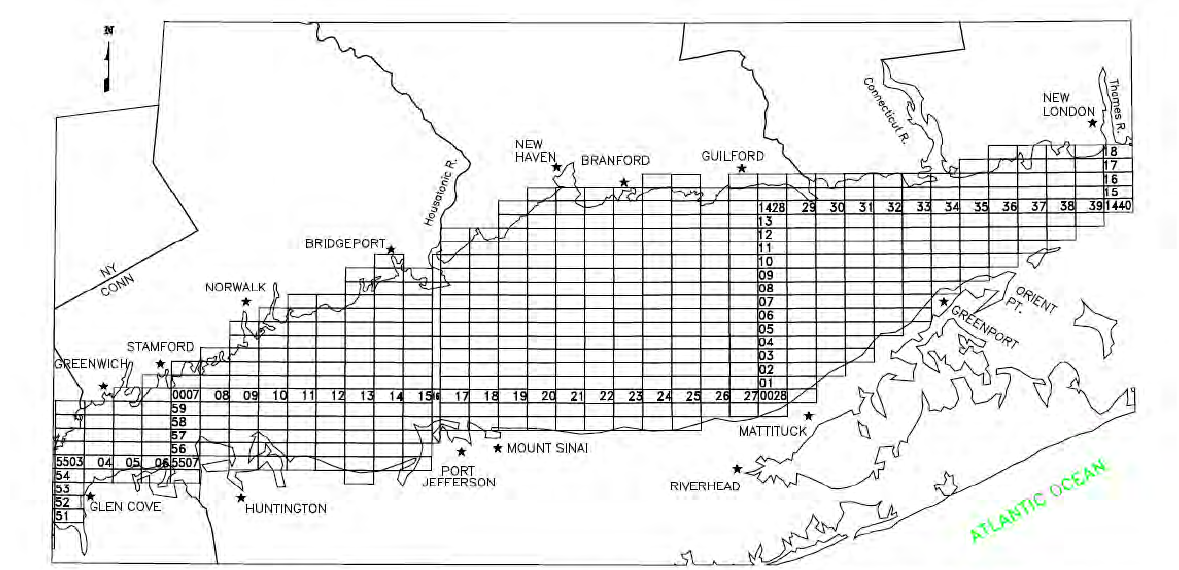
Figure 30. Map pf Connecticut DEEP Long Island Sound Trawl Survey site grid.